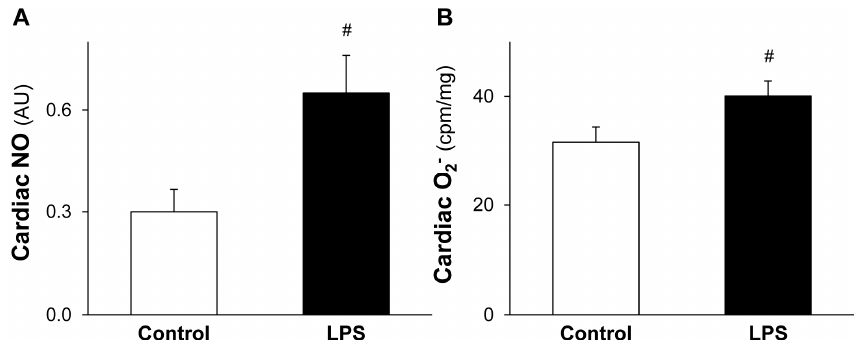
Figure 3. LPS pretreatment leads to increased level of cardiac NO and O 2• − . Figure shows cardiac peroxynitrite precursor nitric oxide (NO) ( A ) and superoxide (O 2• − ) ( B ) levels 24 h after in vivo 0.5 mg/kg lipopolysaccharide (LPS) treatment. Values are expressed as mean ± S.E.M. ( n = 7–12). # p < 0.05 vs. control, unpaired t -test.